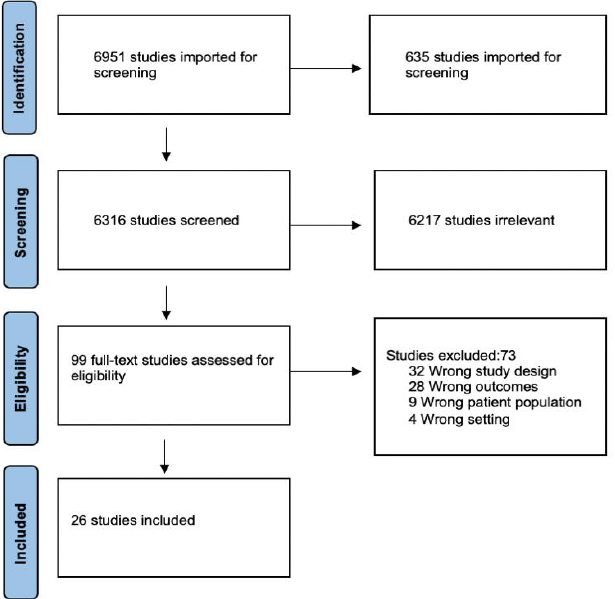
Figure 1. PRISMA flow chart.